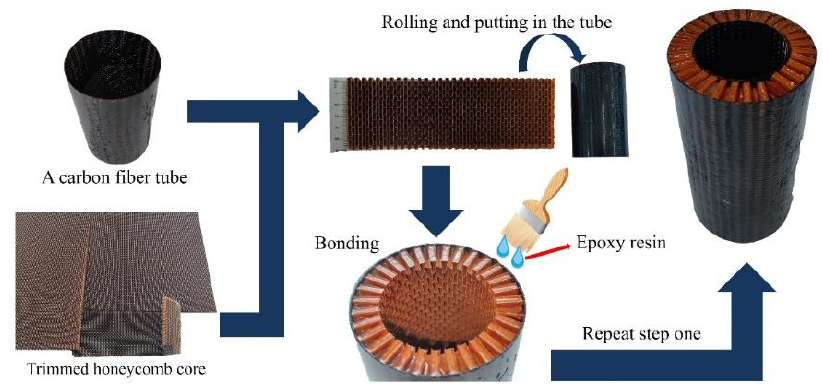
Figure 10. The preparation process and finished product of the AHST.